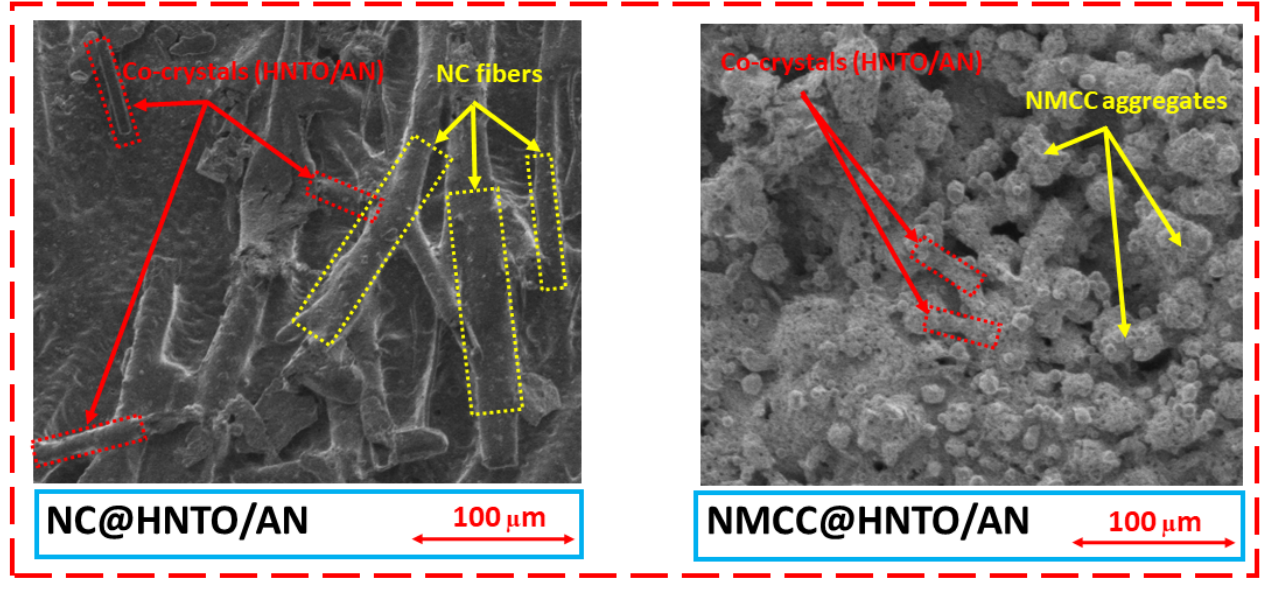
Figure 2. SEM micrographs of the elaborated energetic composites.